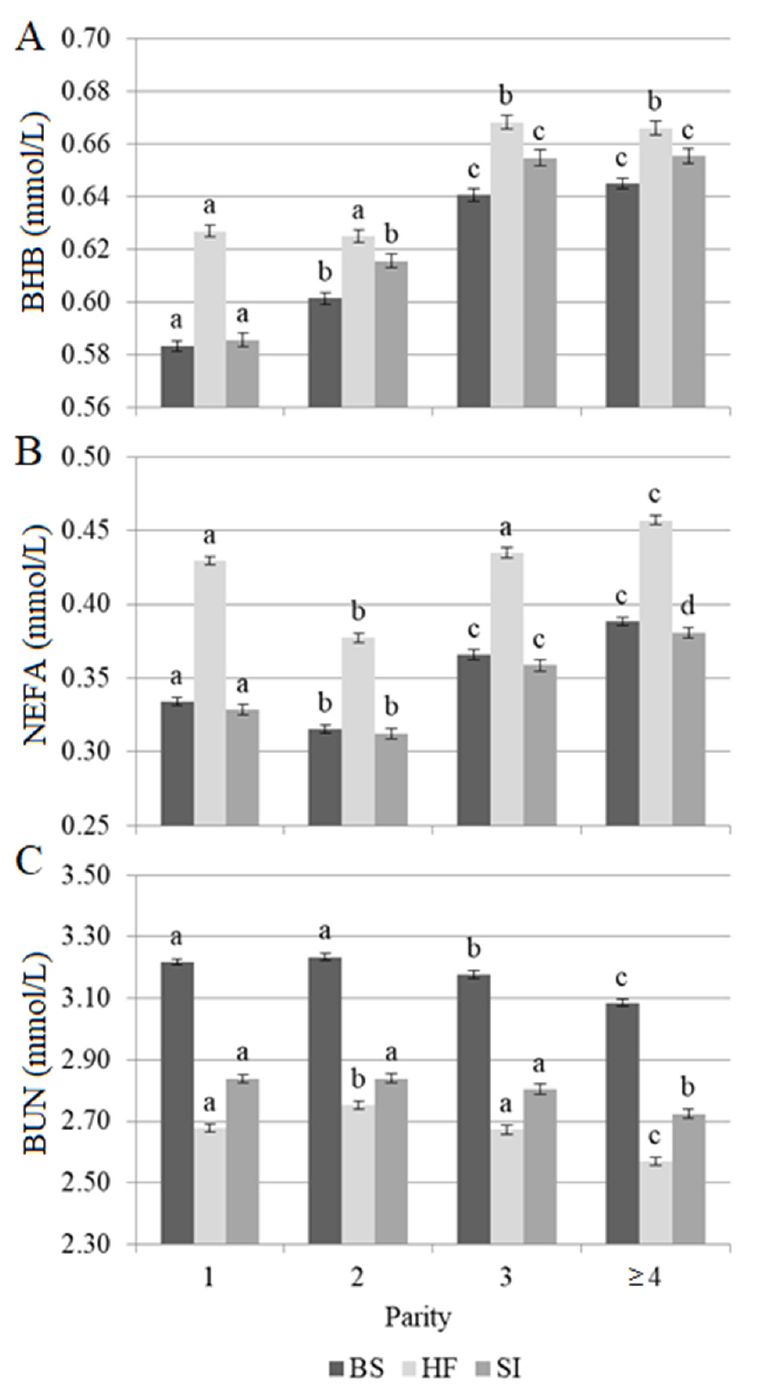
Figure 1. Least squares means of predicted ( A ) blood β -hydroxybutyrate (BHB), ( B ) blood non-esterified fatty acids (NEFA), and ( C ) blood urea nitrogen (BUN) across parity of Brown Swiss (BS), Holstein-Friesian (HF), and Simmental (SI) cows in multi-breed herds. Different superscript letters indicate significantly different least squares means within breed, according to Bonferroni’s test ( p < 0.05). Log 10 -transformed BHB was the trait analyzed as dependent variable in the mixed model; however, for clarity of presentation, least squares means were back-transformed to present results in mmol/L. Vertical bars indicate the standard error.